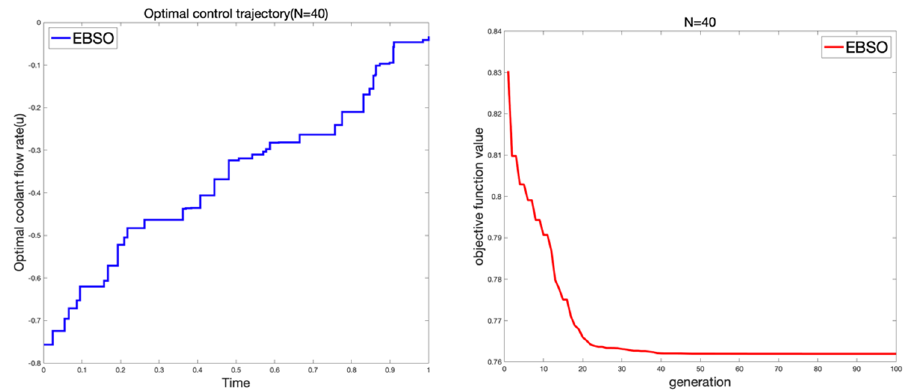
Figure 20. Optimal control trajectory and iteration curve ( N = 40). Table 4. Comparison of methods of Case